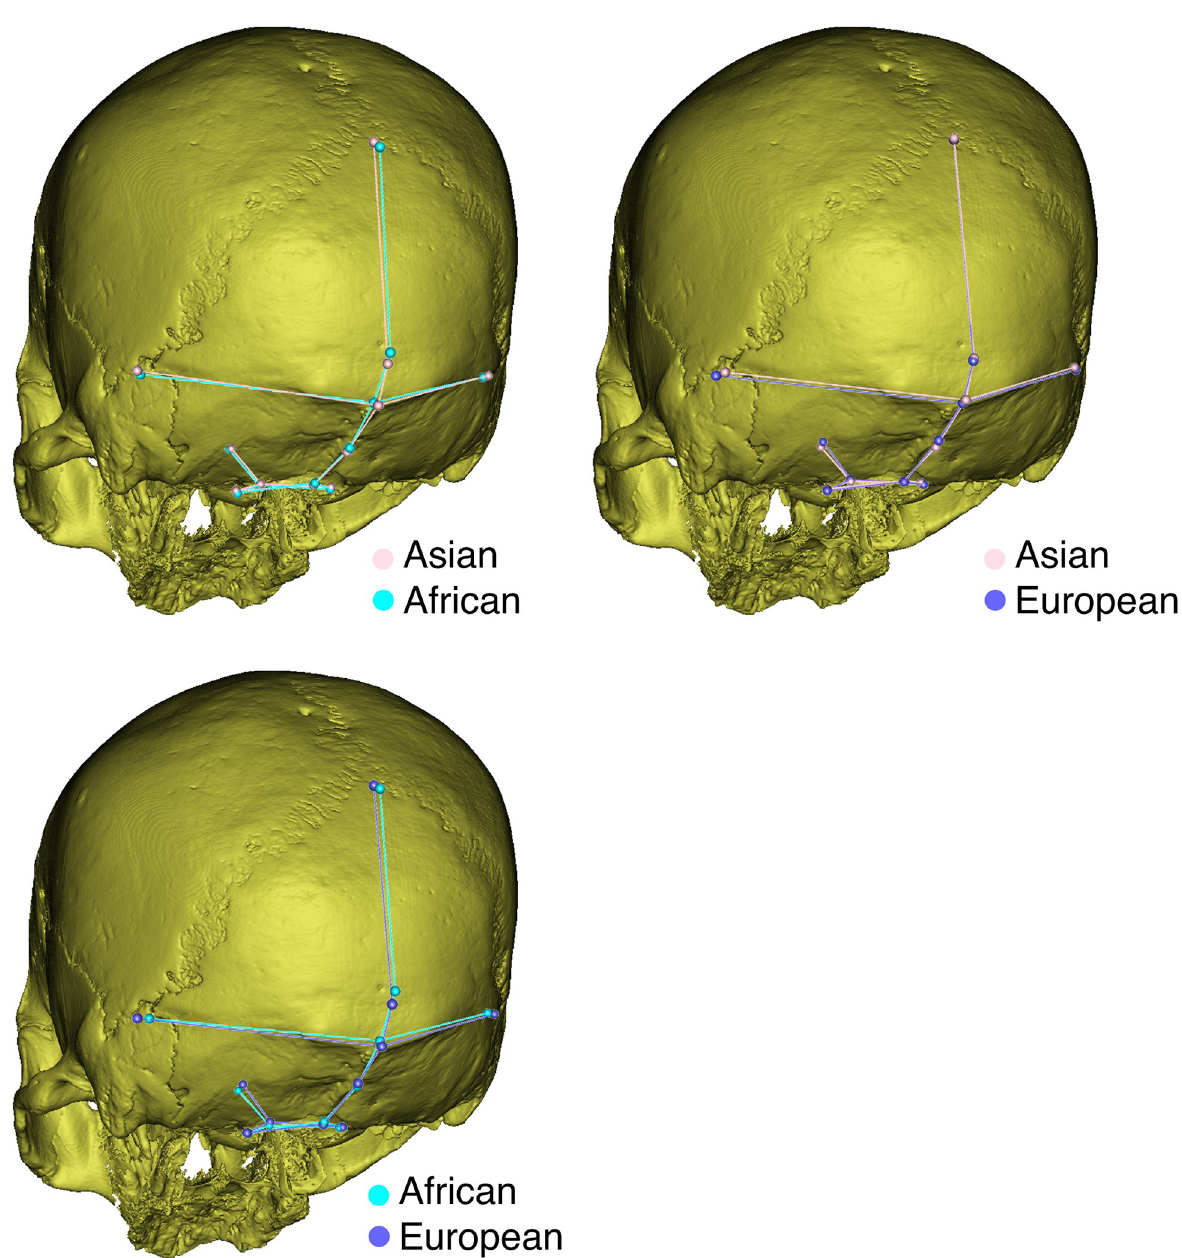
Fig 3. Pairwise population comparisons of average occipital